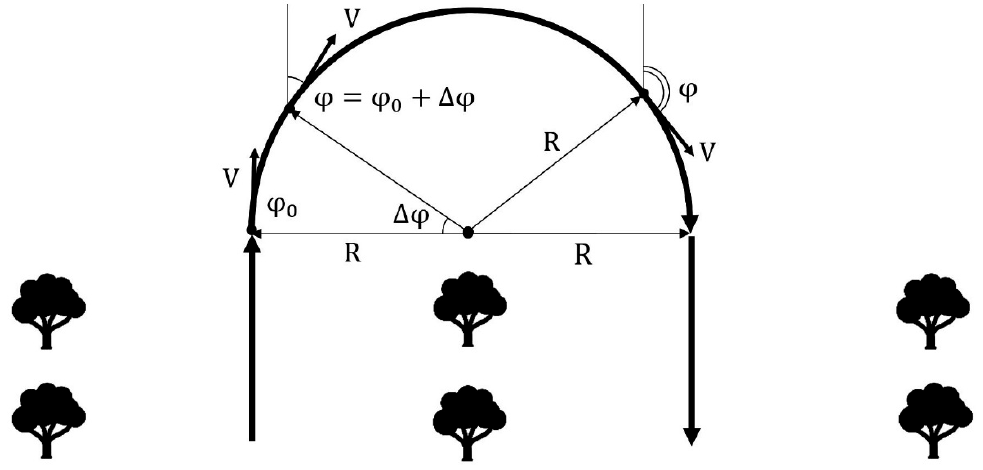
Figure 9. High-level control calculation.